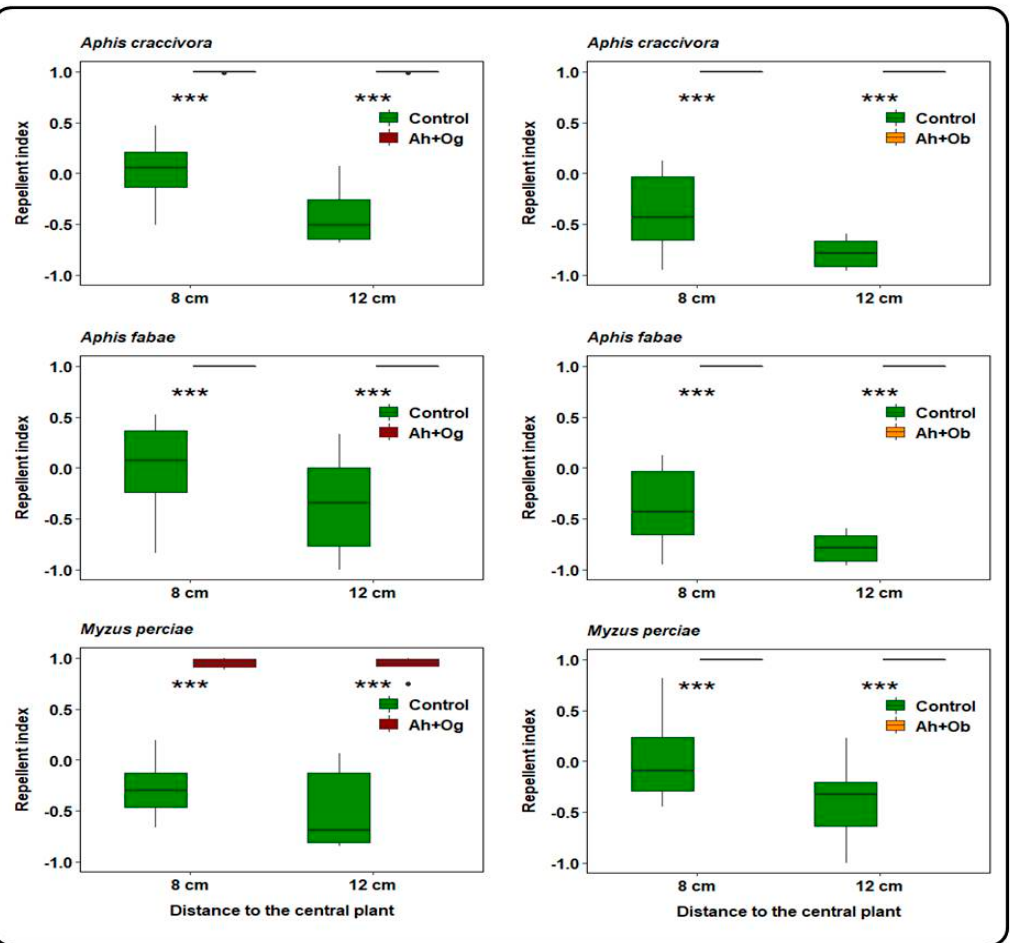
Figure 3. Repellent index towards three aphid species according to the selected plants (8 and 12 cm) comparedtothecentralplant(0cm)ineachmodality. Control: A.hybridus (Ah)alone, Og: O.gratissimum , Ob: O. basilicum. *** p < 0.001.